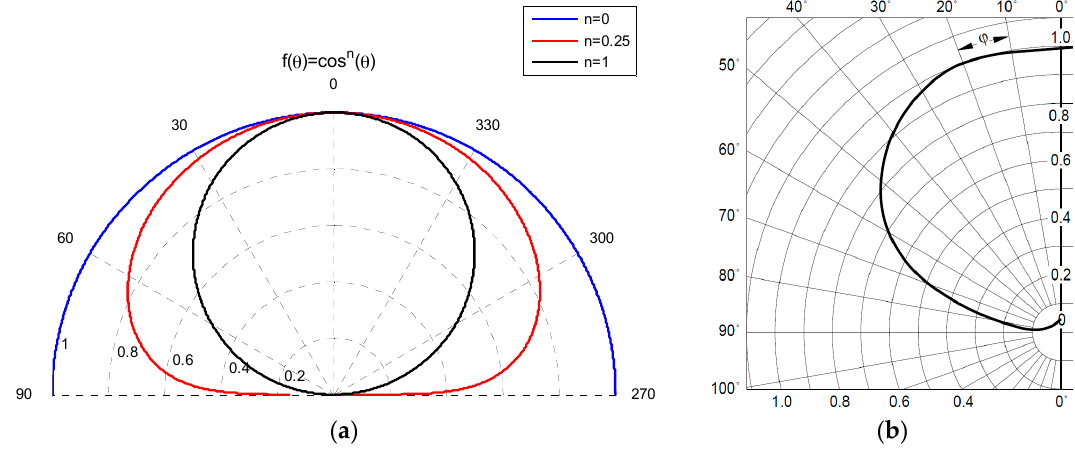
Figure 17. ( a ) Lambertian emission pattern with an index n = 1, 0.25 and 0; ( b ) Representation of the emission pattern of a commercial transmitter with n < 1.